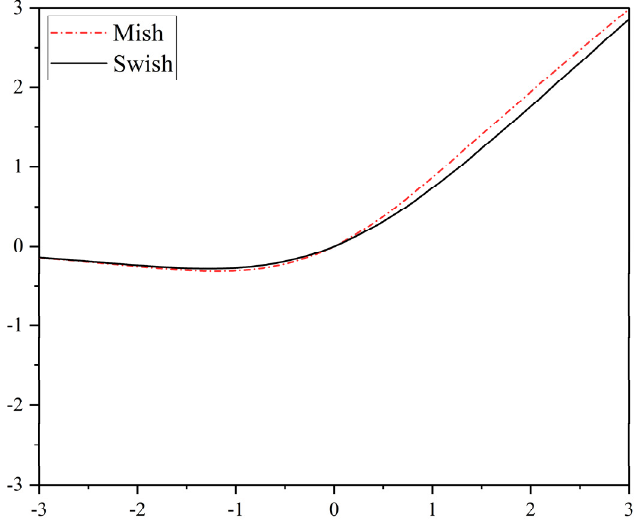
Figure 4. Mish and Swish Activation Function.